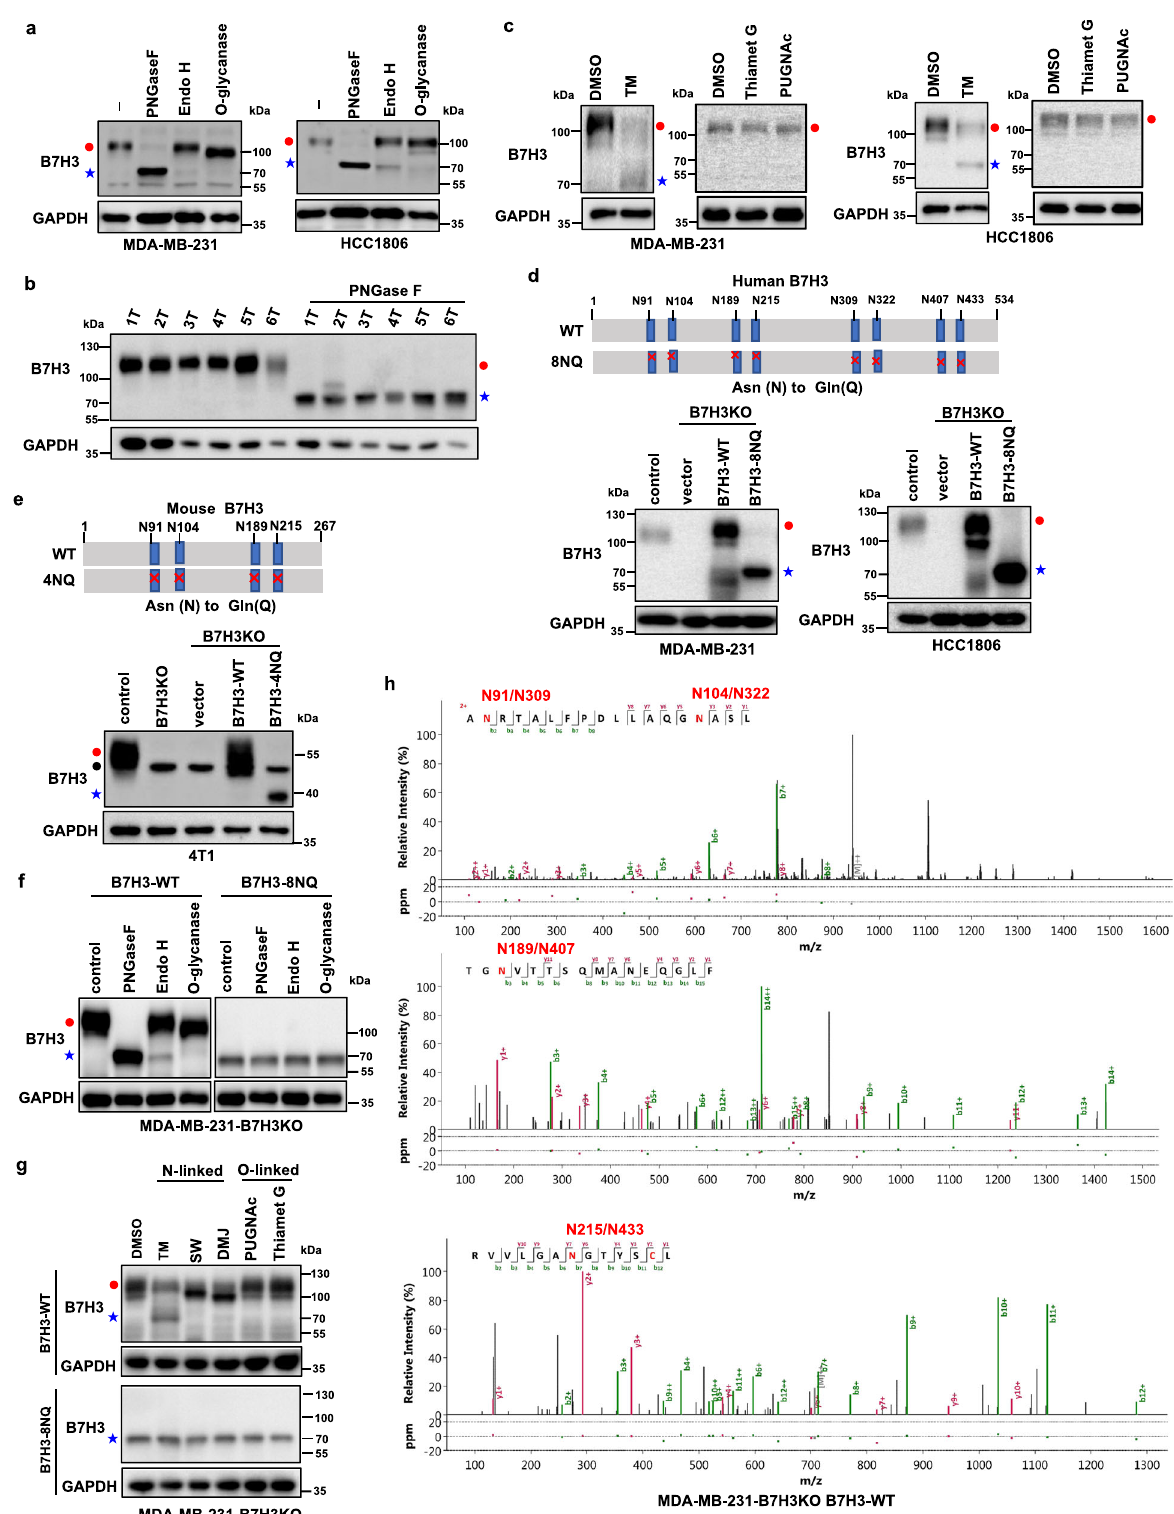
cells in a dose-dependent manner (Fig. 3g). In addititon, B7H3 expression on the cell surface was completely blocked in B7H3- 8NQ and B7H3-4NQ mutant cells (Fig. 3h). Taken together, these results suggest that N-glycosylation of the NXT motif sites is responsible for B7H3 protein stability and its stable expression on the cell